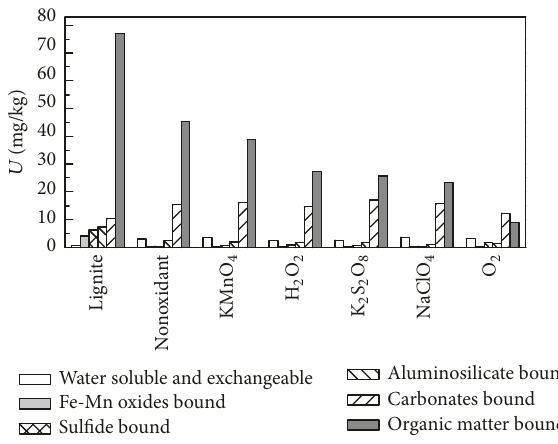
Figure 7: The speciation of uranium in the lignite before and after leaching.